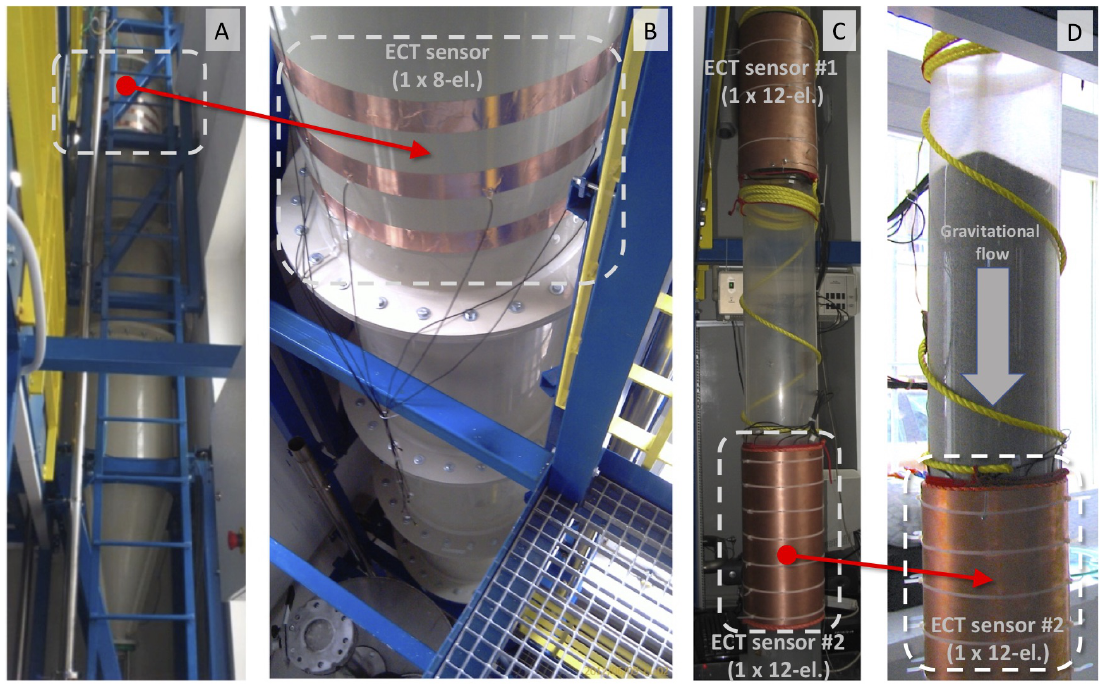
Figure 10. Slim silos at the Tom Dyakowski Process Tomography Lab in TUL. Left: pictures ( A , B ) show an industrial scale 7 m high silo for bulk solid processing equipped with a single plane, inner-mounted, ECT sensor. ( B ) shows a zoom-in view of ECT sensor shown in upper part of ( A ). Right: pictures ( C , D ) show a 2 m experimental silo model with two ECT sensors. ( D ) shows a zoom-in view of ECT sensor shown in lower part of ( C ). ( C ) reveals an empty silo model while ( D ) presents lower part of ( C ) captured during bulk solid flow.